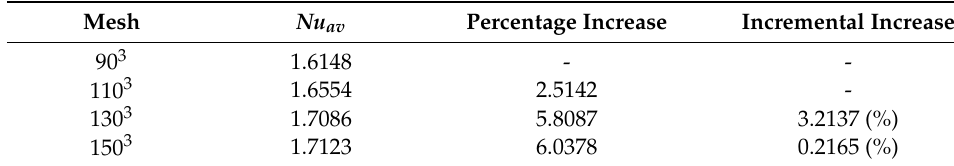
Table 2. Optimised solution.